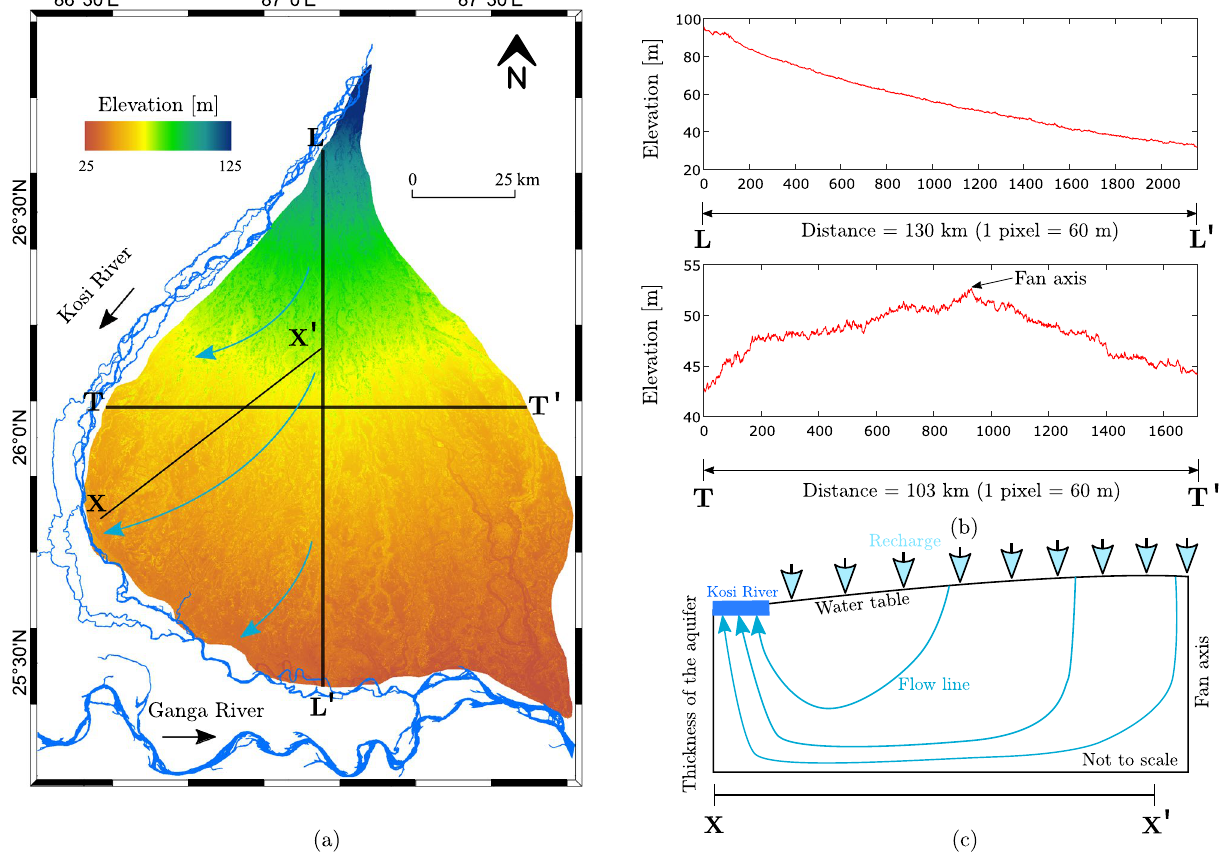
Figure 14. ( a ) Digital elevation model of the Kosi Fan, ( b ) elevation profiles on the fan along the longitudinal (LL’) and transverse (TT’) transects, and ( c ) schematic of the groundwater flow lines from the fan axis towards the western margin of the fan (modified after Khan et al. 109